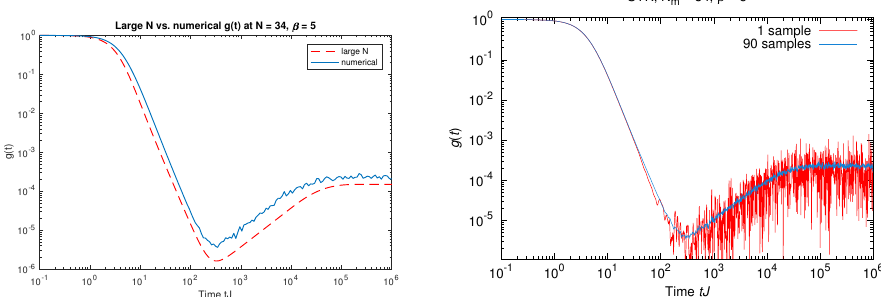
Large N vs. numerical g(t) at N = 34, = 5